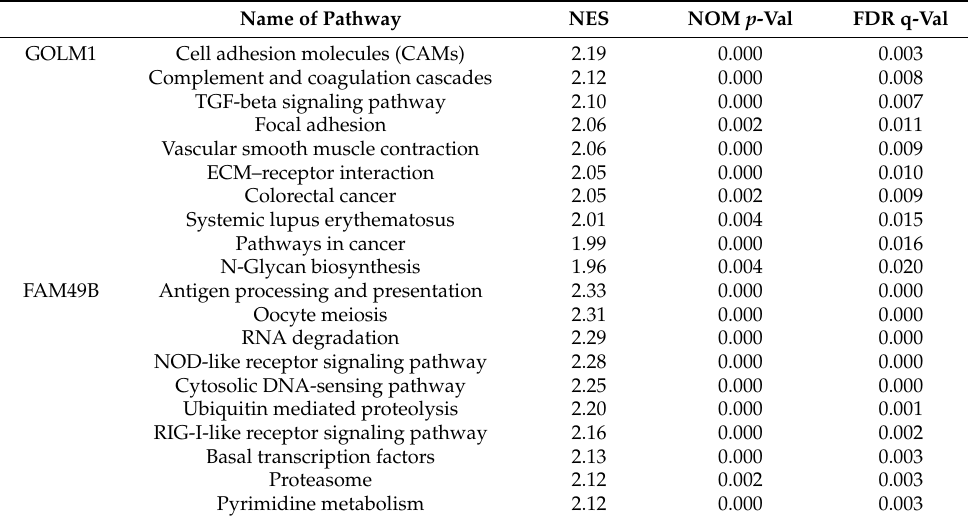
Table 1. Top 10 pathways enriched by GSEA analysis in GOLM1 and FAM49B. Name of Pathway NES NOM p -Val FDR q-Val